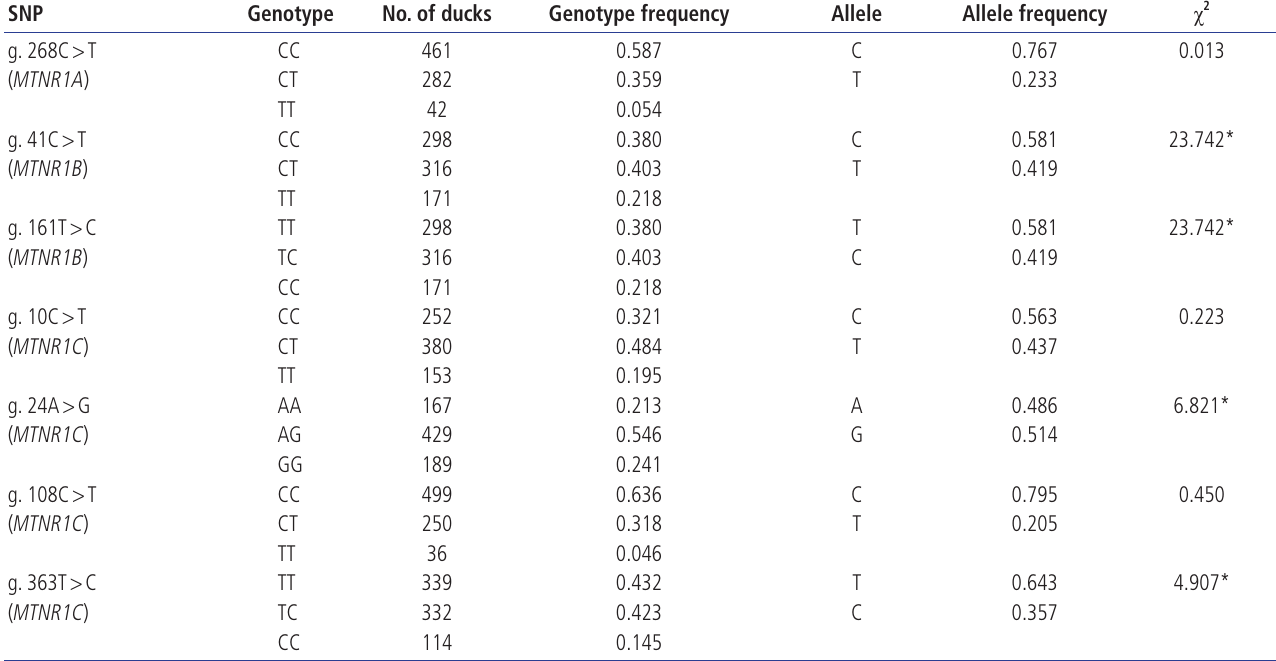
Table 2. Genotypic and allelic frequency at the SNP loci of MTNR1A, MTNR1B, and MTNR1C genes in the Shaoxing duck population